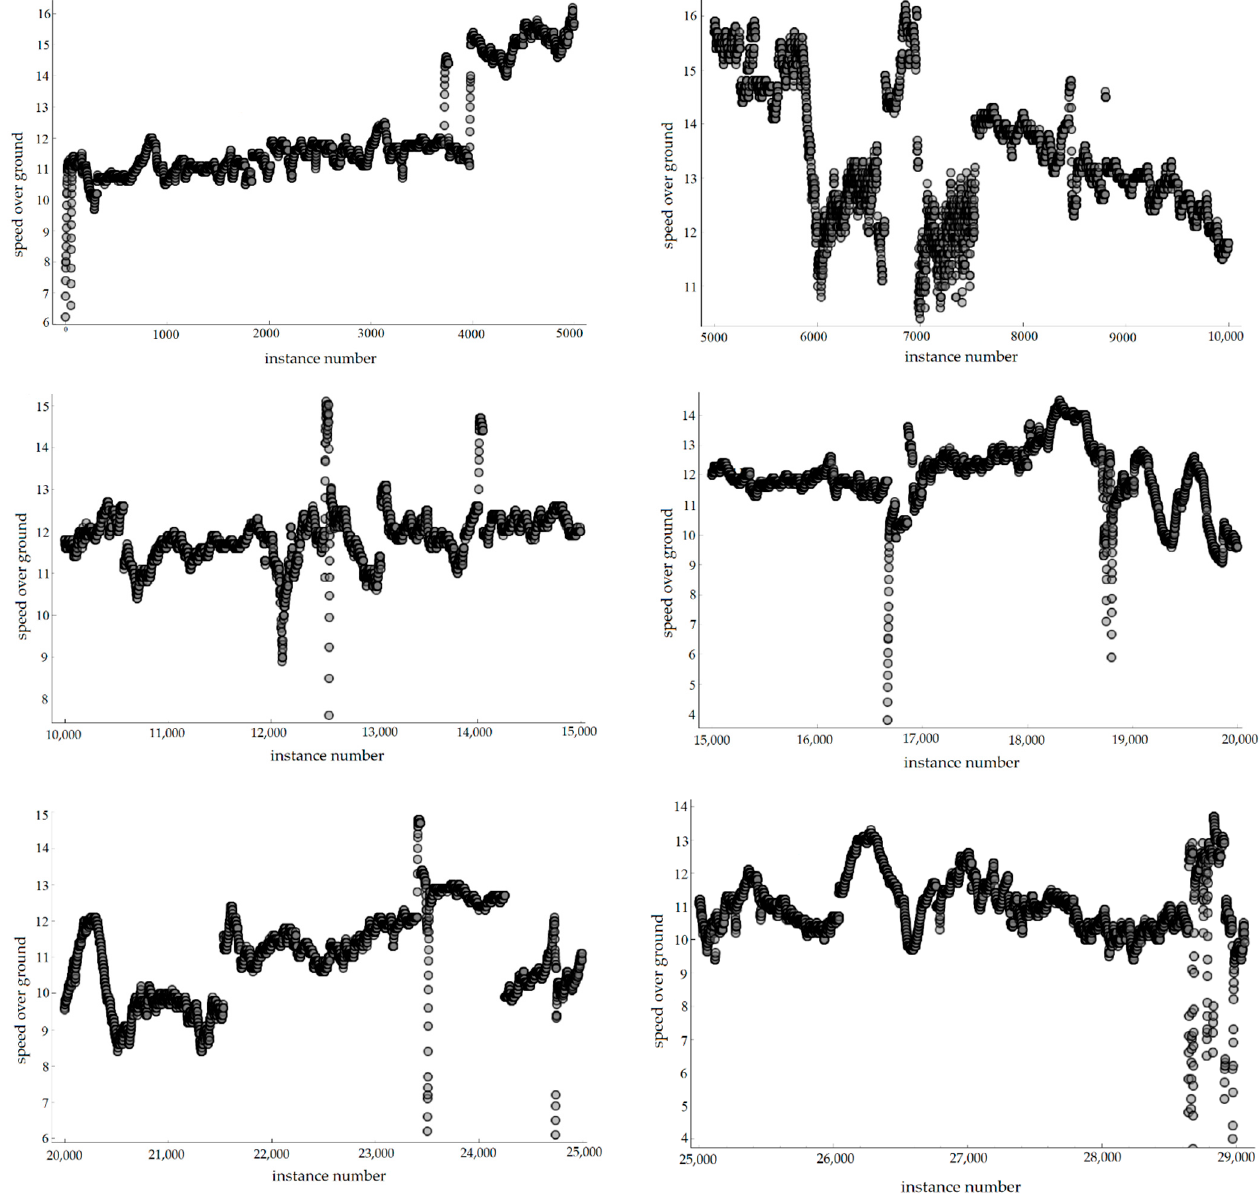
Figure 7. Fluctuation of the ship’s speed.